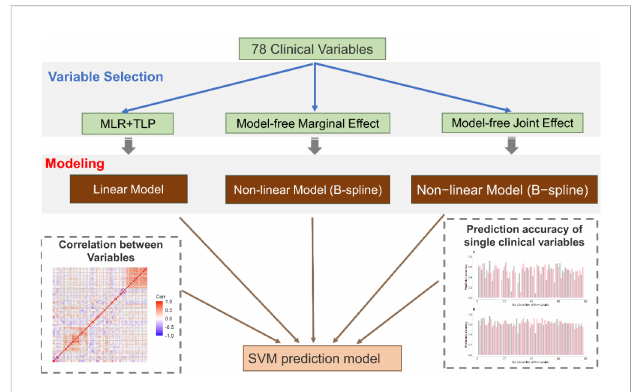
FIGURE 1 Overview of the method. First, we propose a new variable selection procedure to select informative variables. This procedure contains two parts: SVM-based variable selection (MLR+TLP) and model-free variable selection (MAC). Then, by considering the correlation between selected variables, we use a stepwise regression strategy to build our fi nal prediction